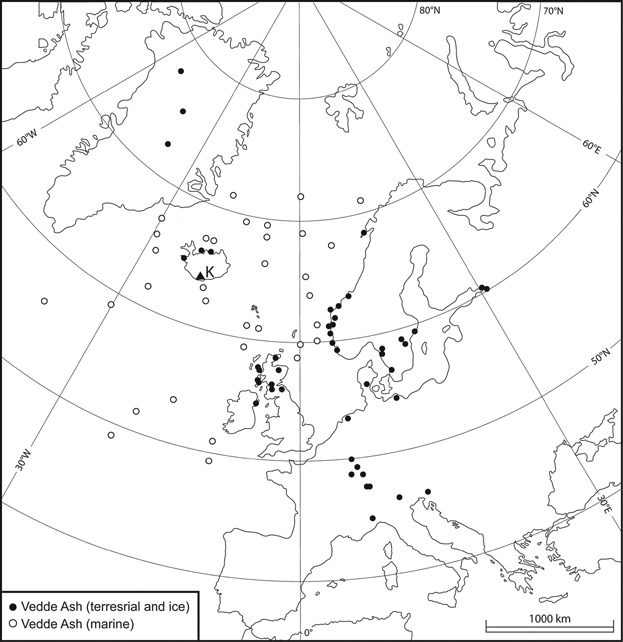
Location of palaeorecords within which the Vedde Ash has been identified. Filled circles mark the location of terrestrial and ice-core sequences and open circles represent marine occurrences. Deposition of Vedde Ash is thought to have been by iceberg rafting between 49 and 55°N and primary fallout north of 55 °N. References for the Vedde Ash occurrences are as follows: Greenland (Grönvold et al., 1995; Mortensen et al., 2005; Rasmussen et al., 2013); Iceland (Björck et al., 1992; Norddahl and Haflidason, 1992; Ingólfsson et al., 1997); Norway (Mangerud et al., 1984; Birks et al., 1996; Bondevik et al., 2001; Vorren et al., 2007; Lind et al., 2013); Sweden (Wastegård et al., 1998; Björck and Wastegård, 1999; Wastegård et al., 2000a; Schoning, 2002; Macleod et al., 2014); Russian Federation (Wastegård et al., 2000b); Scotland (Lowe and Turney, 1997; Turney et al., 1997; Davies et al., 2001; Mackie et al., 2002; Ranner et al., 2005; Pyne-O’Donnell, 2007; Matthews et al., 2011); Northern Ireland (Turney et al., 2006); Netherlands (Davies et al., 2005); Denmark (Larsen and Noe-Nygaard, 2014); France, Germany and Switzerland (Blockley et al., 2007; Walter-Simonnet et al., 2008; Lane et al., 2012a,2012c); Italy (Lane et al., 2012a); Slovenia (Lane et al., 2011a); North Atlantic Ocean (Ruddiman and Glover, 1972; Sigurdsson, 1982; Long and Morton, 1987; Kvamme et al., 1989; Sejrup et al., 1989; Sjøholm et al., 1991; Koç and Jansen, 1992; Bard et al., 1994; Austin et al., 1995; Hunt et al., 1995; Lacasse et al., 1995; Lackschewitz and Wallrabe-Adams, 1997; Thornalley et al., 2011).